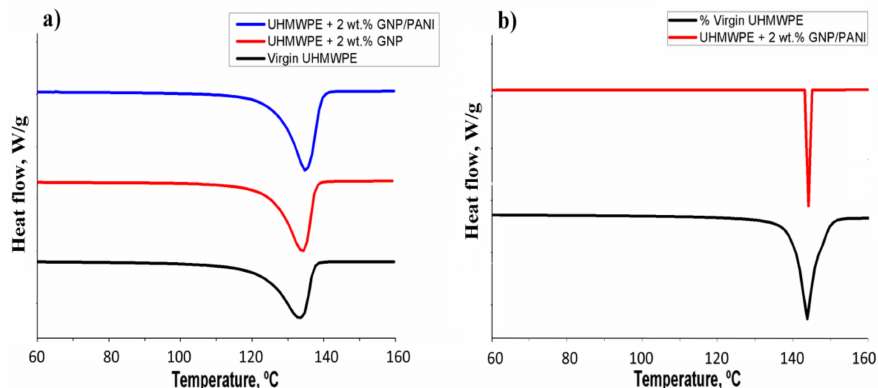
Figure 5. DSC test results for: ( a ) UHMWPE xerogels, ( b ) UHMWPE films.